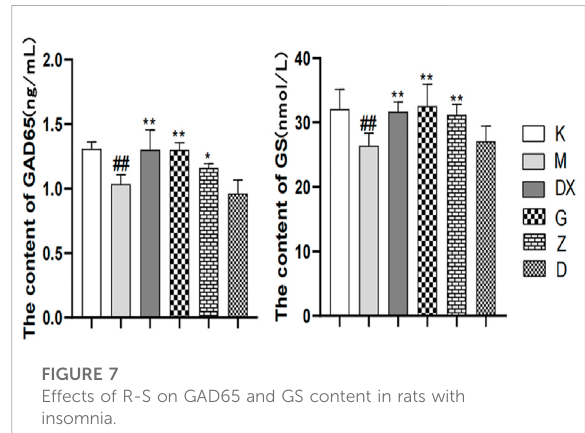
FIGURE 5 Effects of R-S on GABA and GLU content in rats with insomnia.